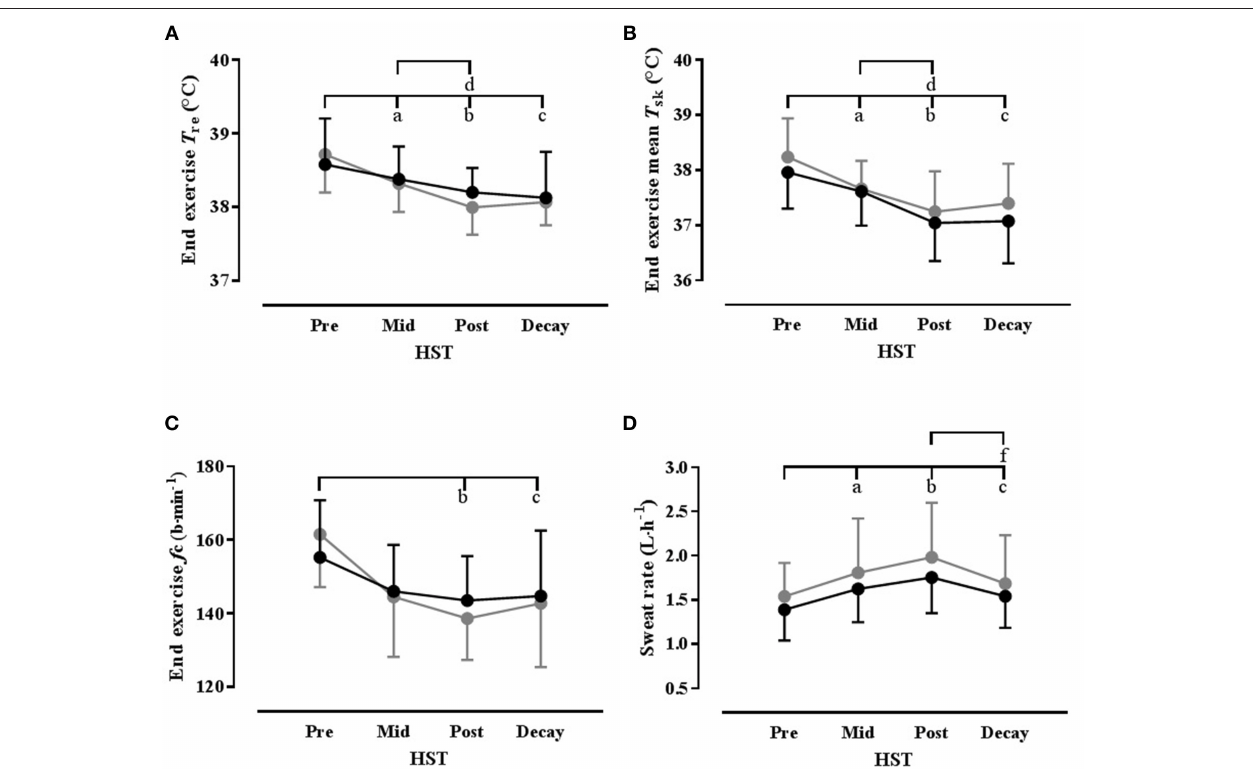
FIGURE 2 | Select thermophysiological variables showing time course of heat acclimation with (HA De : black) and without (HA Eu : gray) permissive dehydration as determined from standard heat stress tests (HST). Data are mean( SD ) and n = 8 unless otherwise stated. (A) End exercise rectal temperature ( T re ); (B) End exercise mean skin temperature ( T Sk ); (C) End exercise mean heart rate ( f c ); (D) Mean HST whole-body sweat rate ( n = 7). Significant post-hoc time effects ( P < 0.05) are denoted by superscripted letter ( a = HST pre vs. HST mid ; b = HST pre vs. HST post ; c = HST pre vs. HST decay ; d = HST mid ; vs. HST post ; e = HST mid ; vs. HST decay ; f = HST post vs. HST decay